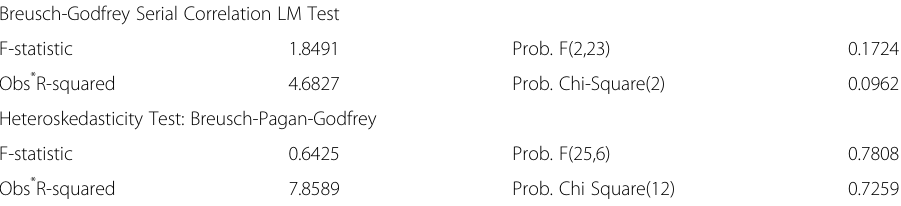
Table 3 Serial Correlation and Heteroskedasticity Test Breusch-Godfrey Serial Correlation LM Test F-statistic